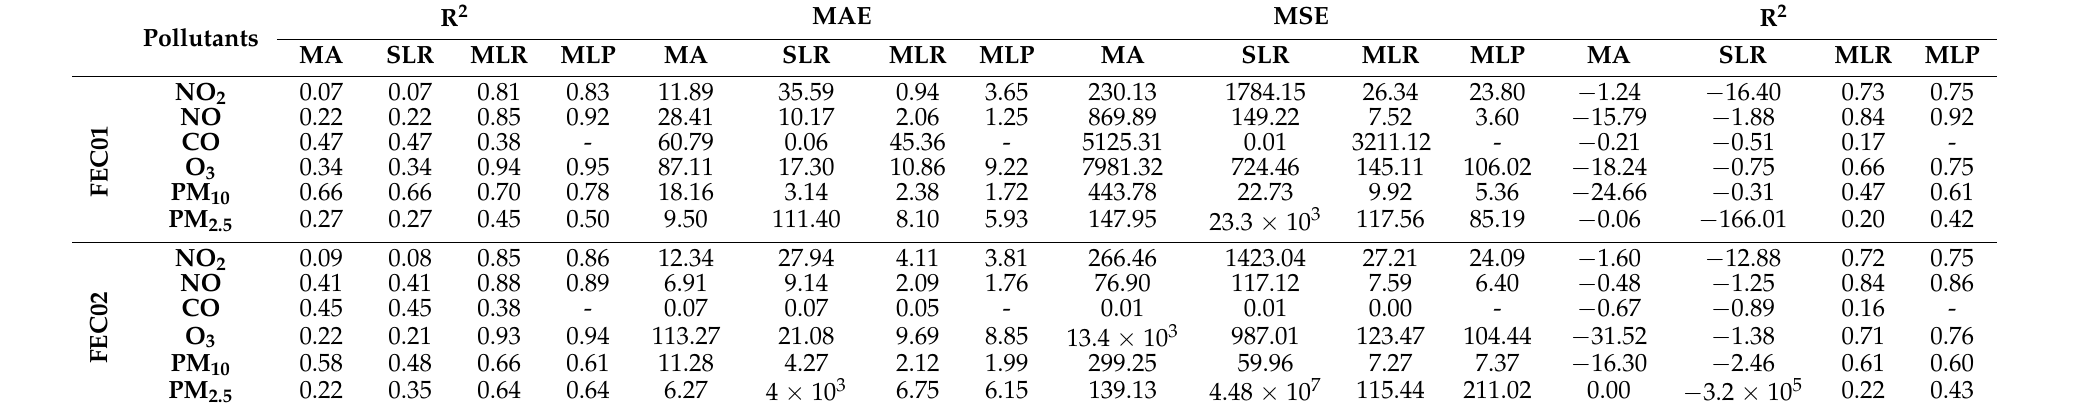
Table 2. Performance statistical indices for the calibration techniques